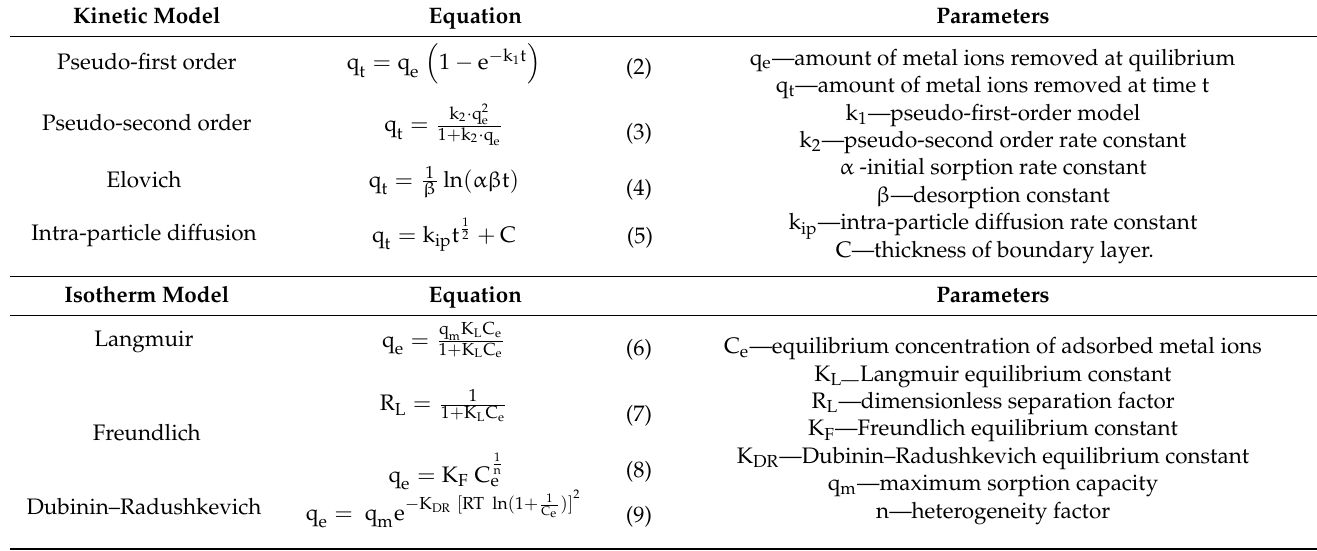
Table 1. Kinetic and isotherm models with equations used to describe sorption